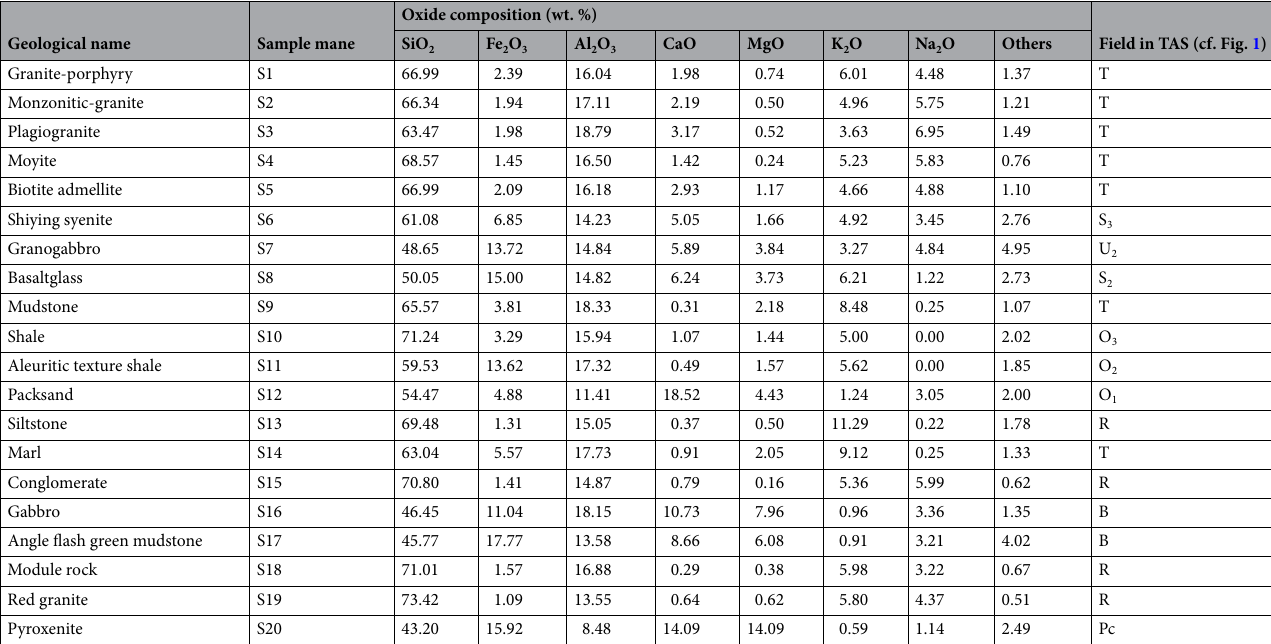
Table 4. Compositions in wt.% of the samples used in the experiment determined using XRF, together with their corresponding TAS